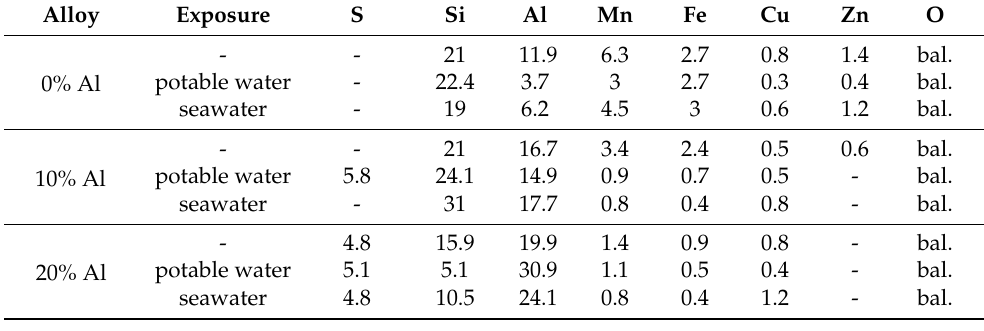
Table 3. Chemical composition of the oxide layer on tested alloys (XPS, at. %) before the exposure (ground surface) and after the exposure to − 0.145 V/SCE.